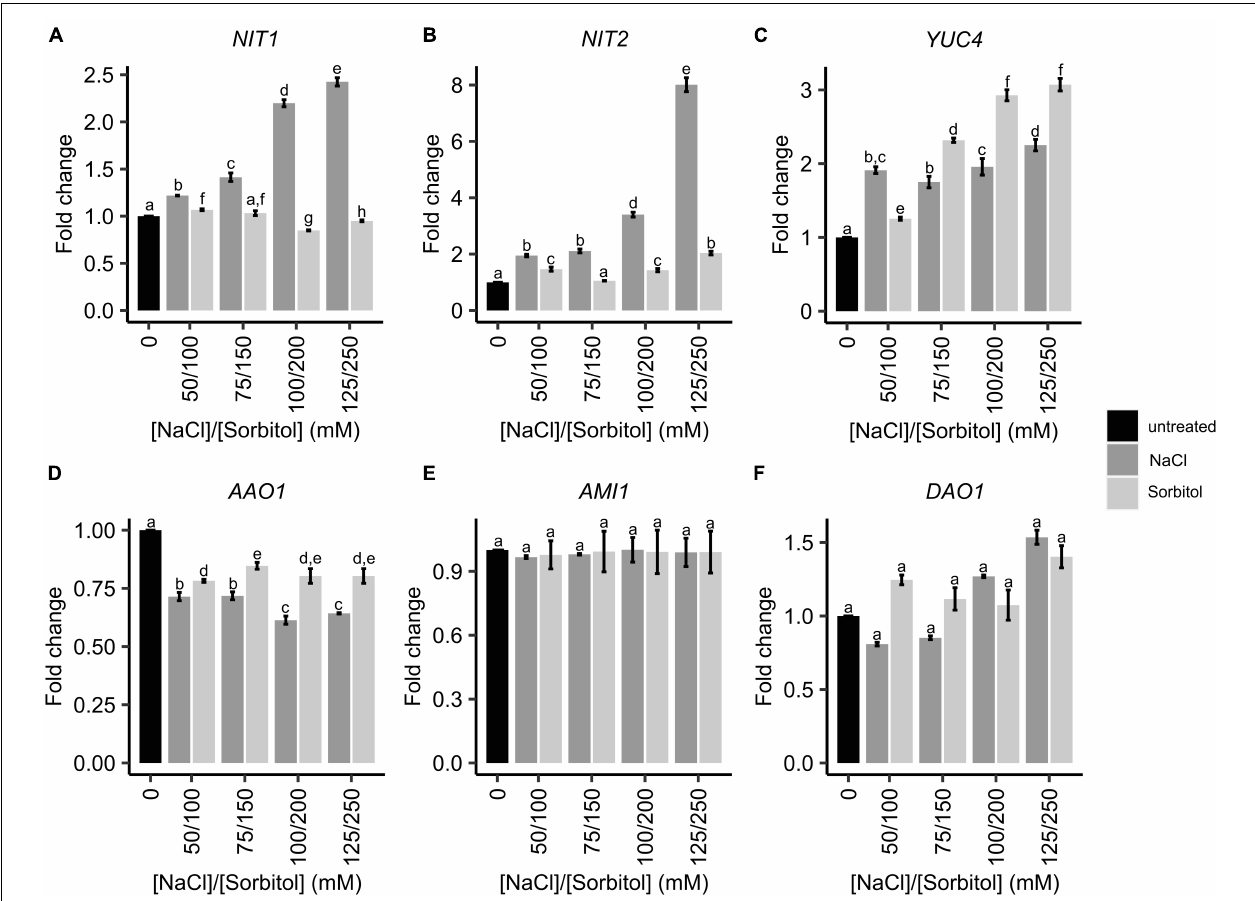
FIGURE 4 | The expression of genes involved in IAA biosynthesis and degradation in Arabidopsis plants grown on NaCl and sorbitol. Arabidopsis Col-0 was germinated and grown for two weeks in petri dishes containing ATS media (0 mM, untreated control) and ATS supplemented with the indicated concentrations of NaCl and sorbitol . Gene expression was determined by microarray analysis. IAA biosynthetic genes include: NIT1 (A) , NIT2 (B) , YUC4 (C) , AAO1 (D) and AMI1 (E) . IAA degradative genes include DAO1 (F) . The black bar represents the untreated control, dark grey bars represent NaCl treatments and light grey bars represent sorbitol treatments. All microarray results are shown as the mean fold change relative to the untreated control (0 mM). The average was calculated from three biological repeats. Error bars represent standard error. Different letters on the graphs indicate statistically significant differences ( p ≤ 0.05) in mean fold change as determined by one way ANOVA followed by Fisher LSD post-hoc analysis. NIT2 : Nitrilase 2, NIT1 : Nitrilase 1, YUC4 : Flavin monooxygenase-like enzyme 4, AAO1 : Arabidopsis aldehyde oxidase 1, AMI1 : Indole-3-acetamide 1, DAO1 : Dioxygenase for Auxin degradation